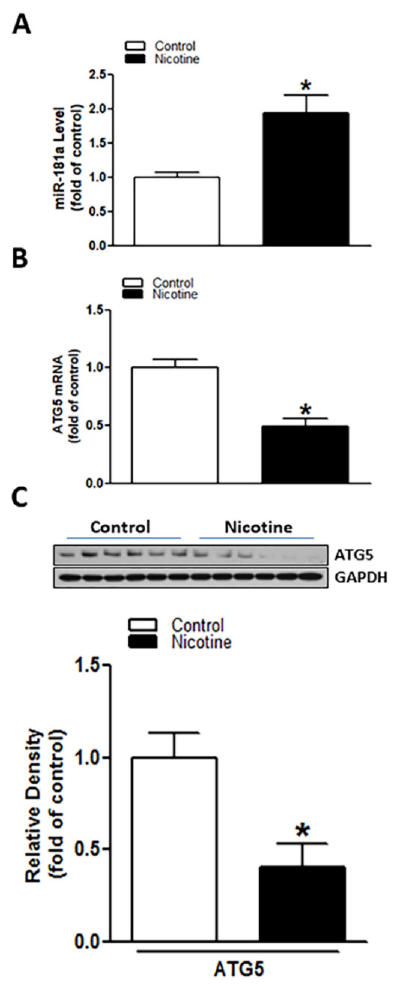
Figure 1. Perinatal nicotine exposure induced miR-181a over-expression and autophagy-related gene 5 (ATG5) repression in neonatal rat brain. Brains were isolated from 9-day-old neonatal rat pups in both saline control and nicotine exposed groups. qRT-PCR analysis was employed to evaluate levels of miR-181a ( A ) and ATG5 mRNA ( B ), respectively. ATG5 protein abundance ( C ) was determined by Western blotting. As demonstrated, perinatal nicotine treatment significantly enhanced expression level of miR-181-a ( A ) but attenuated both mRNA and protein levels of ATG5 ( B , C ) in the neonatal rat brains. Data are means ± SEM. * p < 0.05, control vs. nicotine. n = 4–6